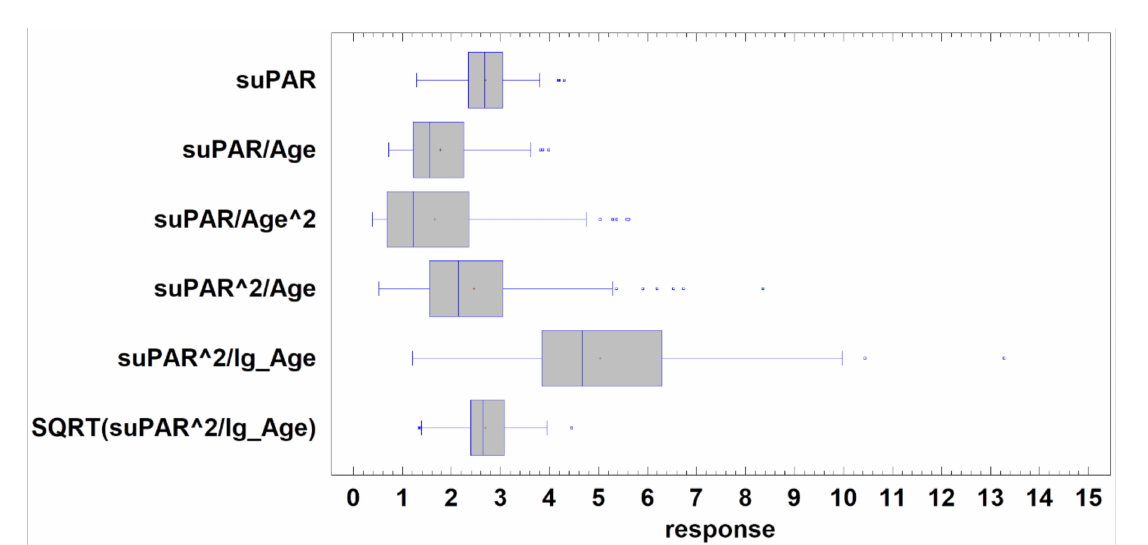
Figure 1. Soluble urokinase-type plasminogen activator receptor (suPAR) level in serum (ng/mL) and calculated body inflammation indeces (no units) separating the measure from patient age influence (average value is marked by red cross, median is marked by vertical line inside the boxes). Note: similarity of SQRT(suPARˆ2/lg_Age) to raw data. All calculations performed according Equations